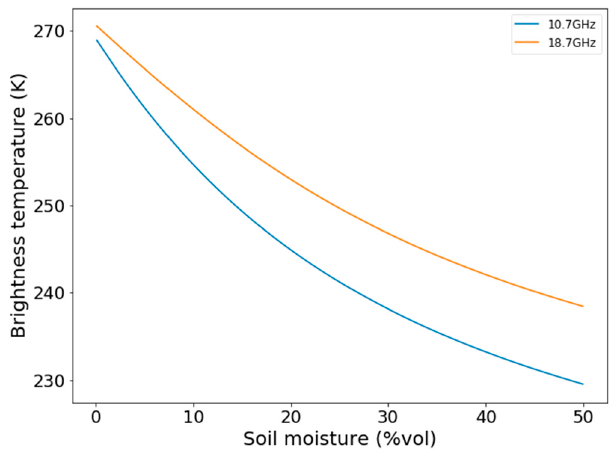
Figure 3. Sensitivity of brightness temperatures (vertical polarization) to soil moisture at 10.7 (blue line) and 18.7 (orange line) GHz (55° viewing angle), based on the [50] rough bare soil reflectivity model (implemented in the HUT model) (soil temperature: 283 K and soil roughness = 0.2 cm).